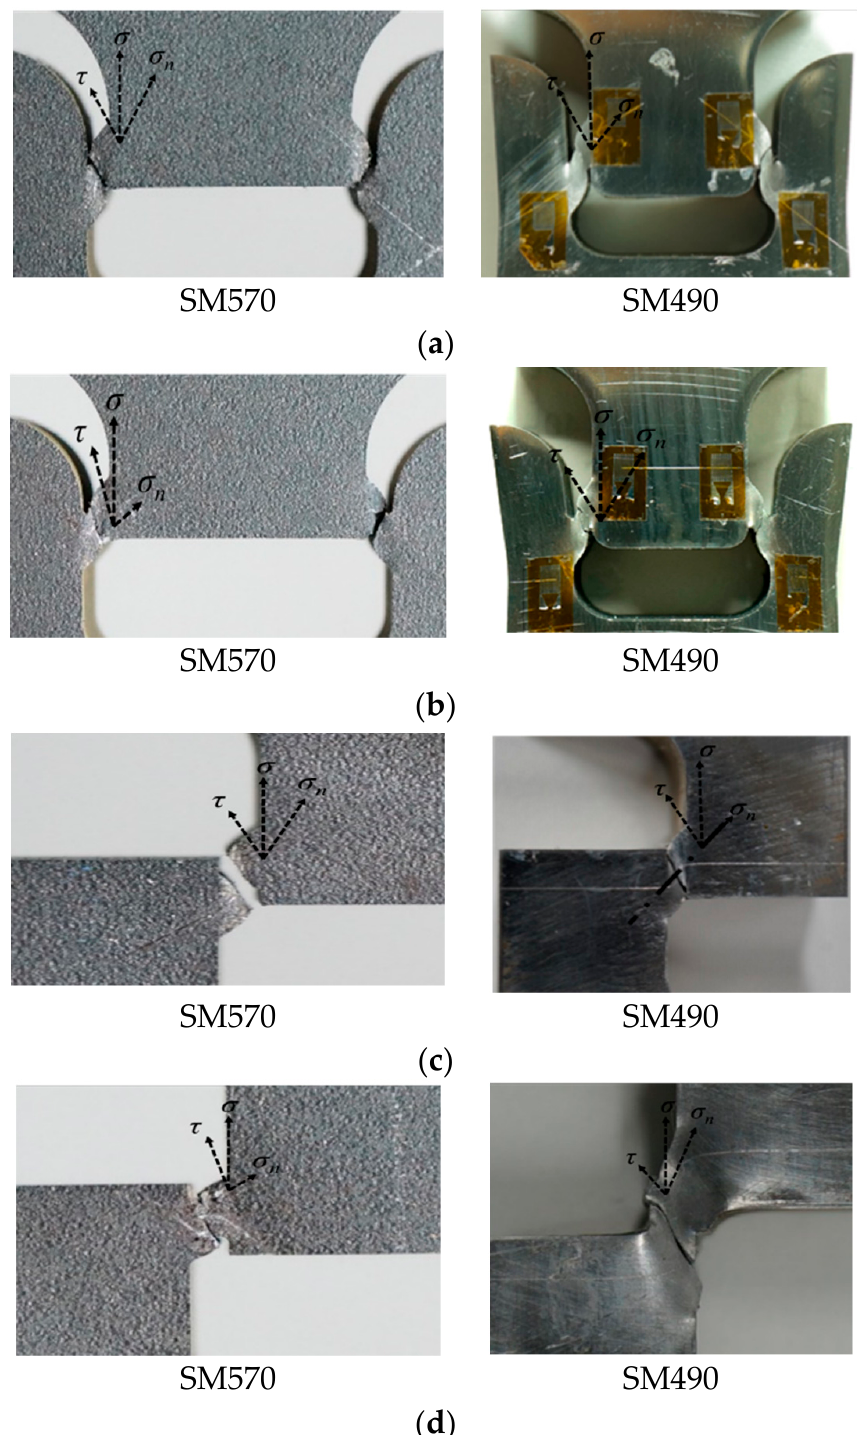
Figure 9 Figure 9. Photographs of fracture failure: ( a ) SYM-Shear+45 ◦ specimens; ( b ) SYM-Shear − 45 ◦ speci- mens; ( c ) USYM-Shear+45 ◦ specimens; ( d ) USYM-Shear − 45 ◦ specimens. More details for the test results of SM490 can be found in the literature